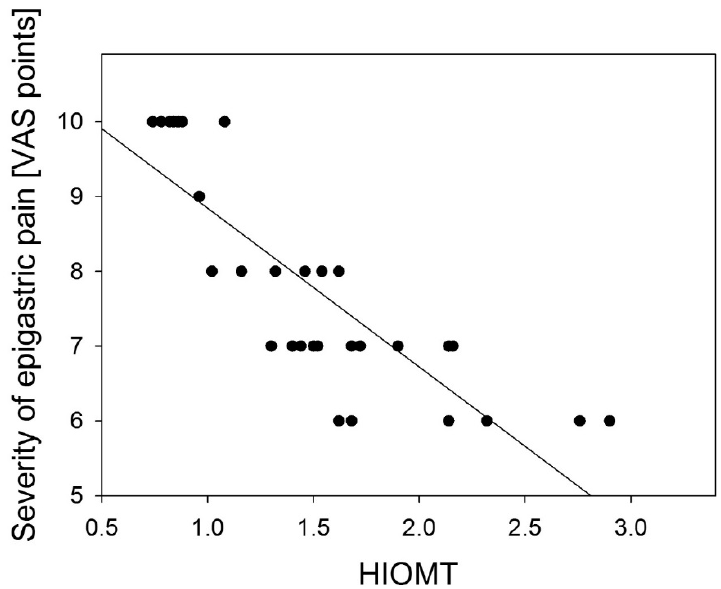
Figure 6. Correlation between hydroxyindole- O -methyltransferase (HIOMT) expression assessed as relative quantity of mRNA of HIOMT and hypoxanthine phosphoribosyltransferase (reference) by RT-PCR in antral gastric mucosa and the severity of epigastric pain assessed by Visual Analog Scale (VAS) in patients with continuous epigastric pain syndrome ( n = 30). Regression line was calculated by means of the last square method, the R value was equal to − 0.833, p < 0.001.